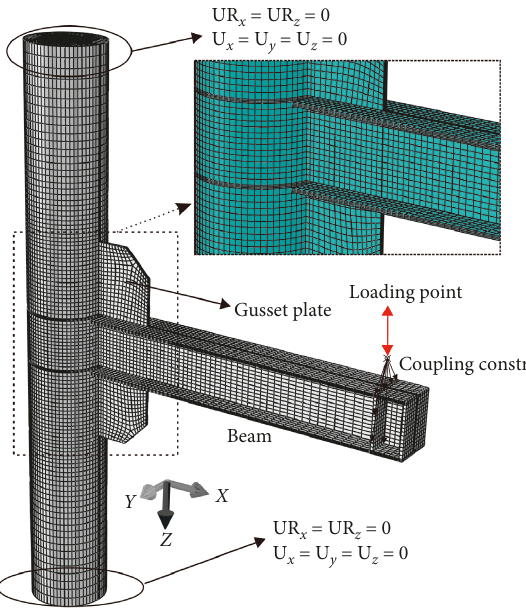
Figure 15: Finite element model and mesh. Table 5: Validation between experiment and finite element